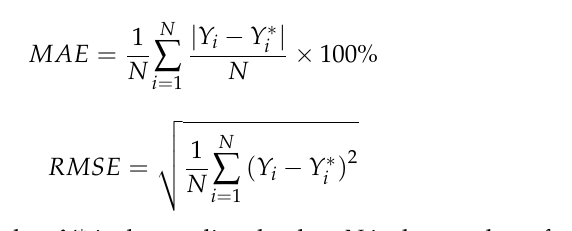
Figure 10. Comparison of prediction results of exponential degradation model and SVR.